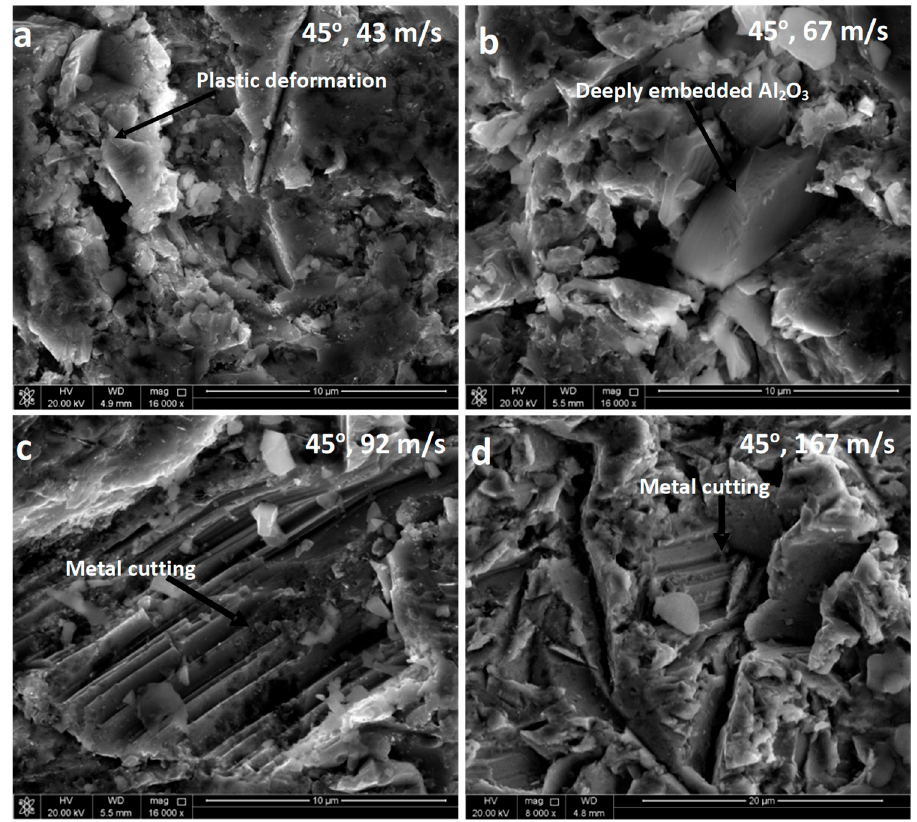
Figure 7. SEM micrograph of steel specimen after erosion at 45° impact angle and different particle speeds of ( a ) 43 m·s − 1 , ( b ) 67 m·s − 1 , ( c ) 92 m·s − 1 , ( d ) 167 m·s − 1 .